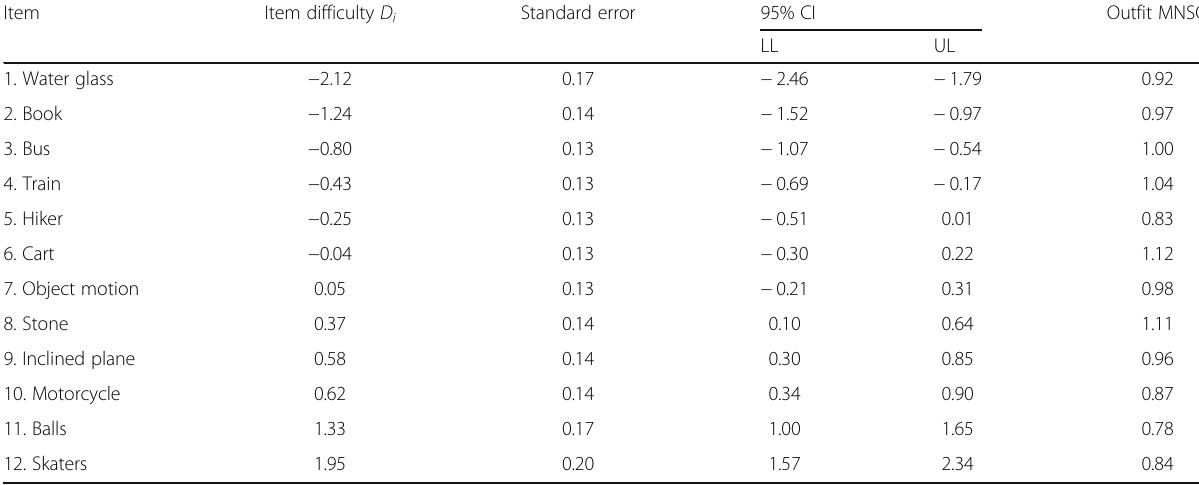
Table 2 Item difficulty D i , standard error of D i , 95% confidence interval of D i , and outfit mean-square (MNSQ) for the 12 items